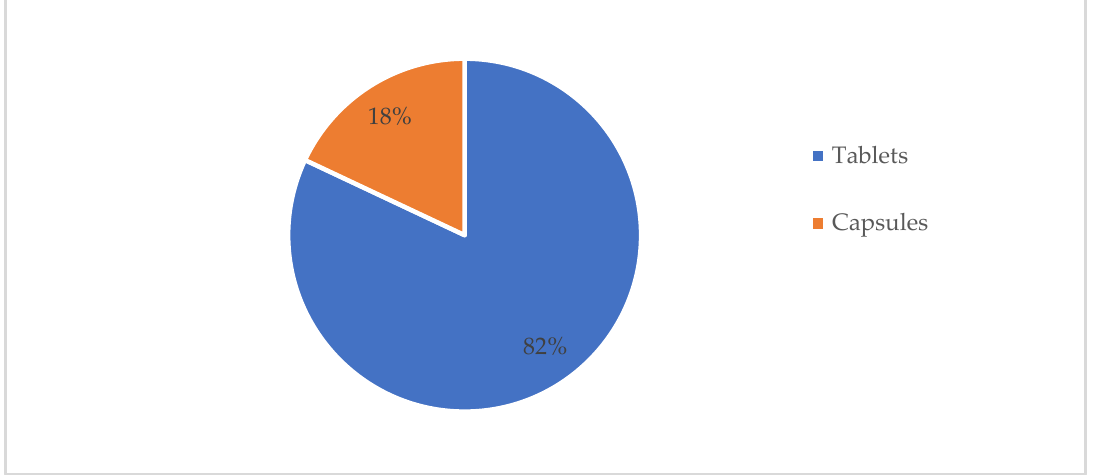
Figure 1. Distribution of the total selected drugs based on the solid dosage forms. Based on the presence or absence of the score line, the tablet dosage form was divided into two groups: scored line tablets, with 39 drugs, and non-scored line tablets, with 126 drugs (Table 1). According to the matching and evaluation results, tablets